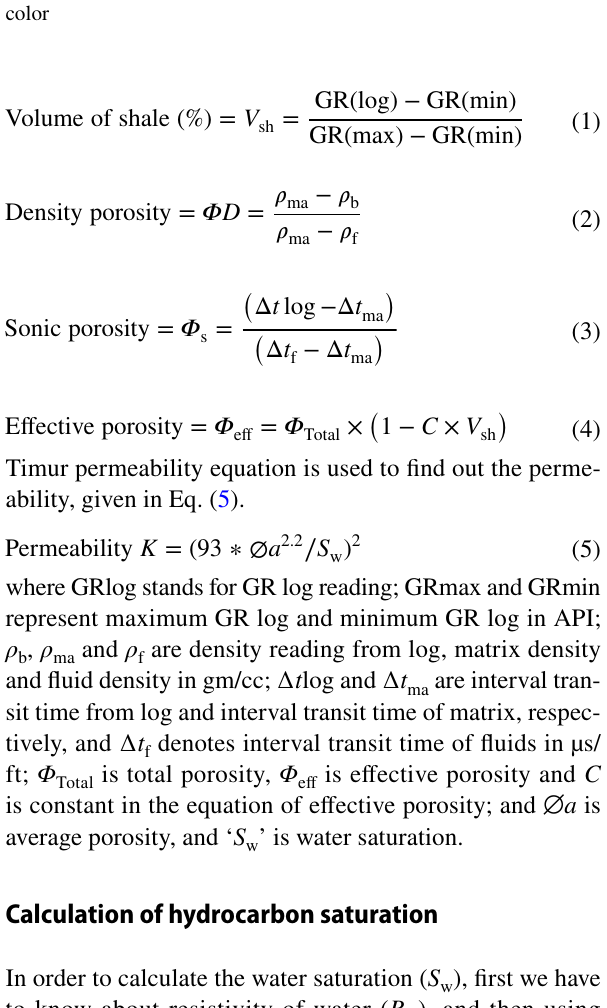
Fig. 4 Base map of wells generated on digital elevation model (DEM) data of the Meyal Oil Field. The studied wells are encircled in yellow